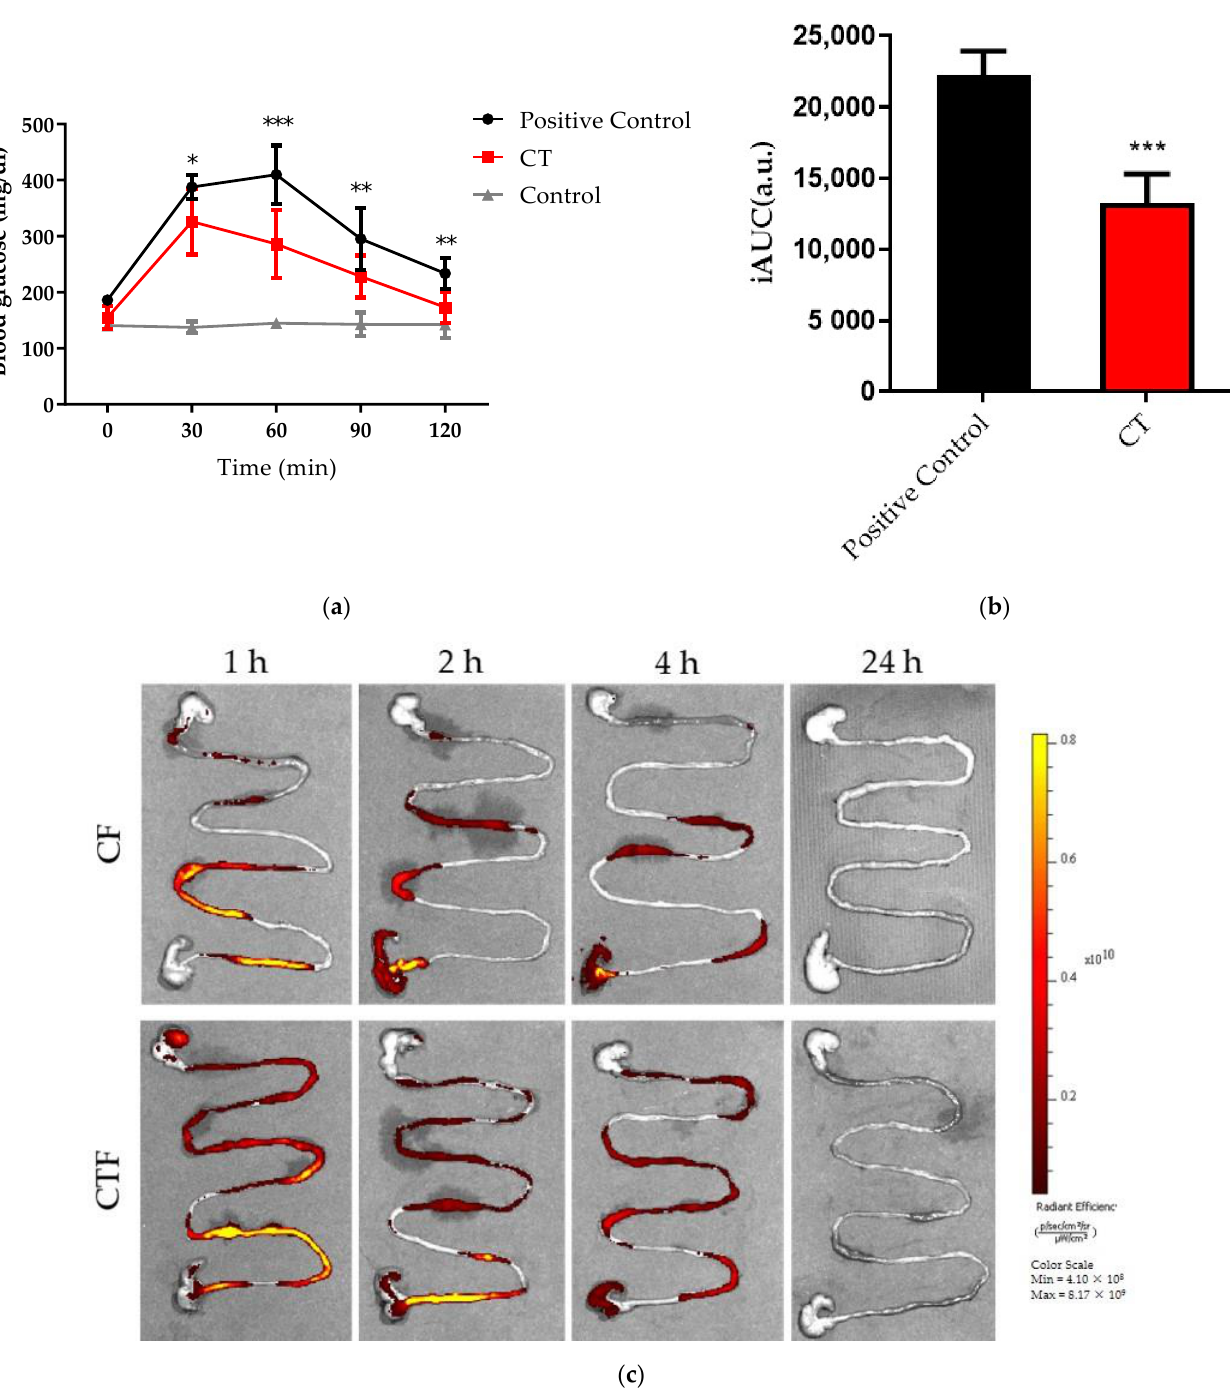
Figure 3. Oral glucose tolerance and in vivo adhesion evaluation. ( a ) Blood glucose response post-CT gavage (250 mg/kg). Two-way ANOVA with multiple comparisons ( n = 6, * p < 0.1 ** p < 0.01 *** p < 0.001). ( b ) iAUC of the OGTT curves. One-way ANOVA with multiple comparisons ( n = 6, * p < 0.1 ** p < 0.01 *** p < 0.001 compared to positive control) ( c ) Gastrointestinal tracts of mice were harvested from the stomach to cecum after gavage with CF or CTF (250 mg/kg) at each time point followed by IVIS in vivo imaging systems.